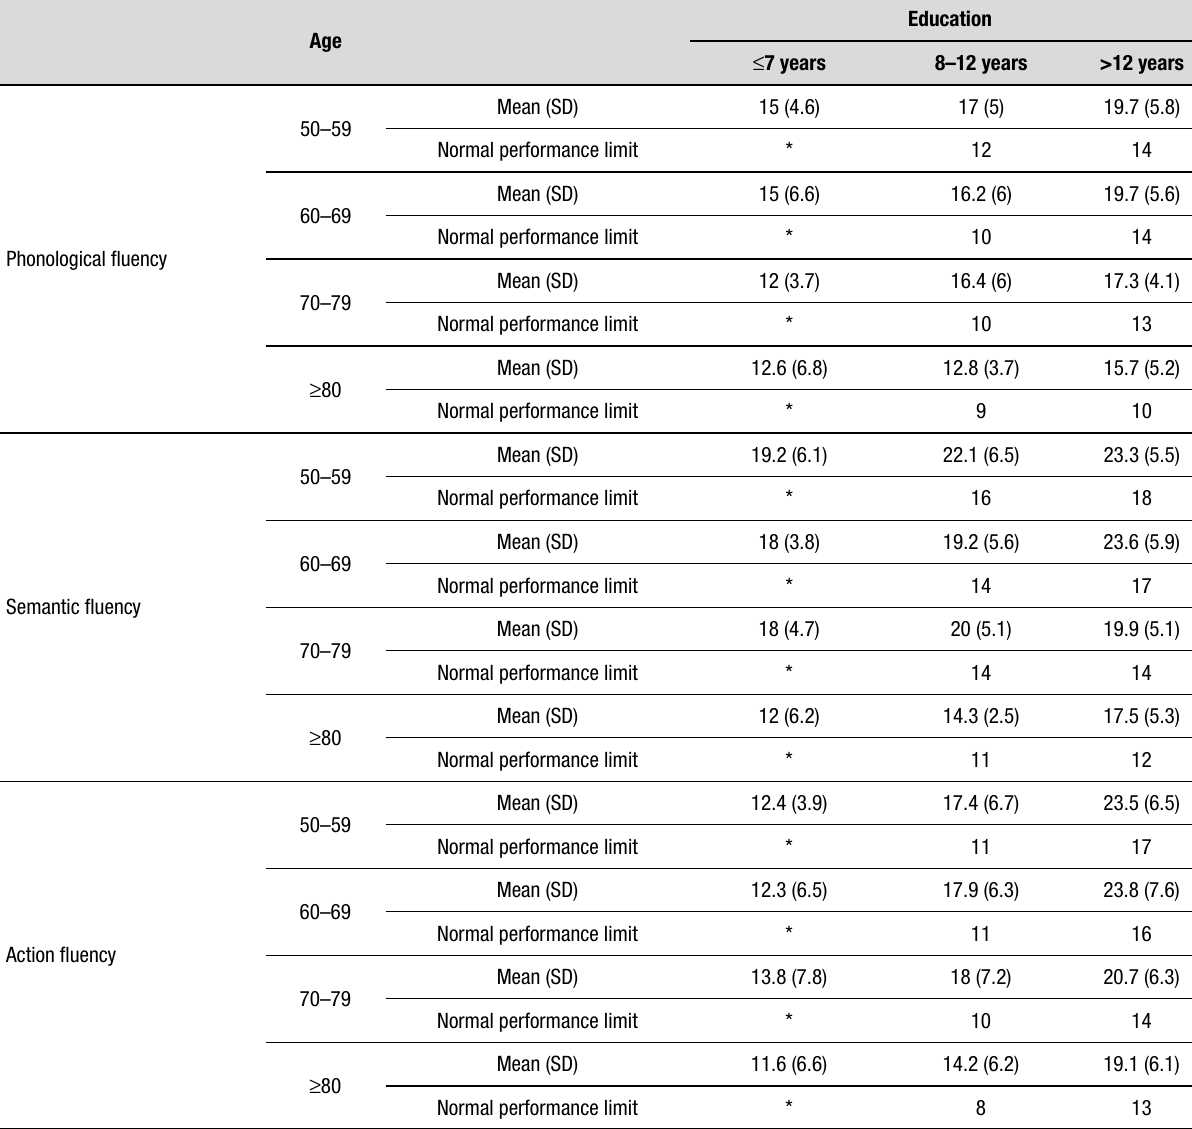
Table 3. Normative data for three verbal fluency tasks in Argentines over 50 years old according to age and education